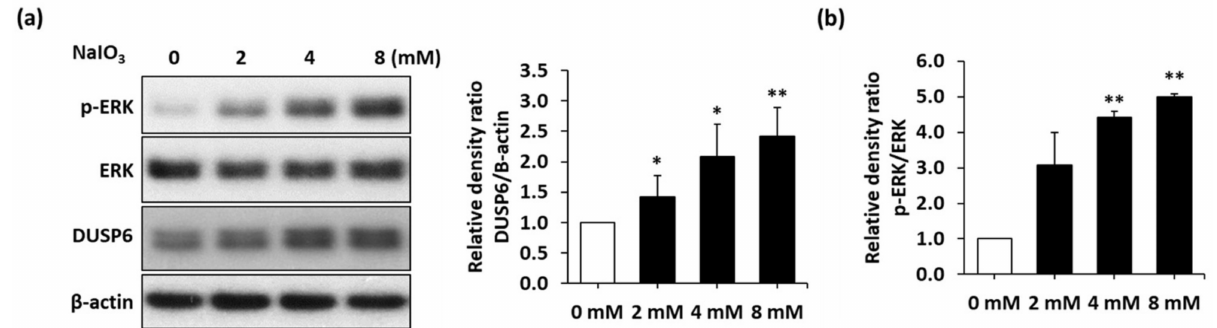
Figure 2. Upregulation of DUSP6 and MAPK after NaIO 3 treatment. ( a ) Representative blots of DUSP6/p-ERK axis expression in ARPE-19 cells after NaIO 3 treatment and the quantitative analysis of the DUSP6 expression level. ( b ) Quantitative analysis of the p-ERK level. Representative data from three independent experiments are shown. * p < 0.05 and ** p <